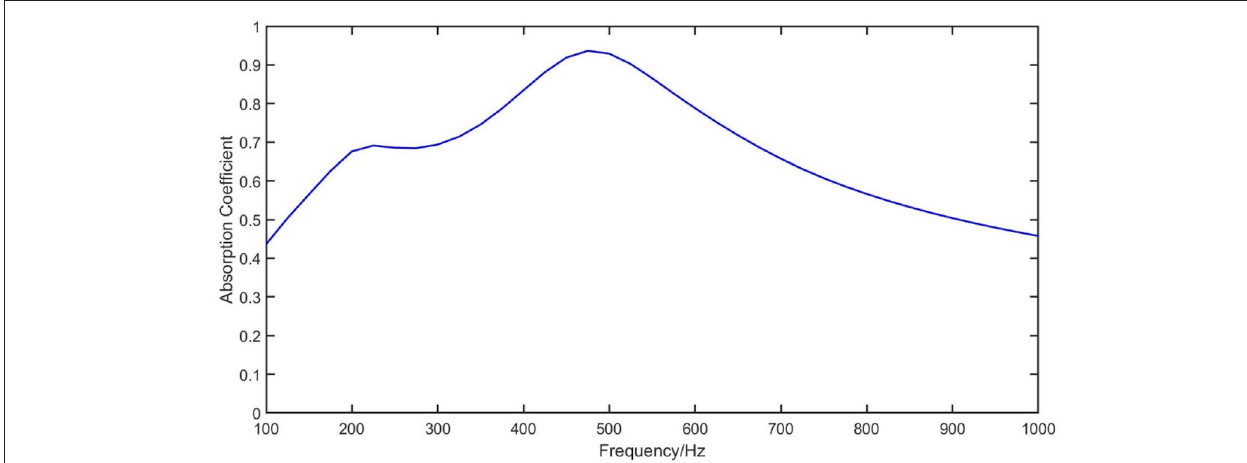
FIGURE 7 | Sound absorption coefficient of the composite structure underwater.